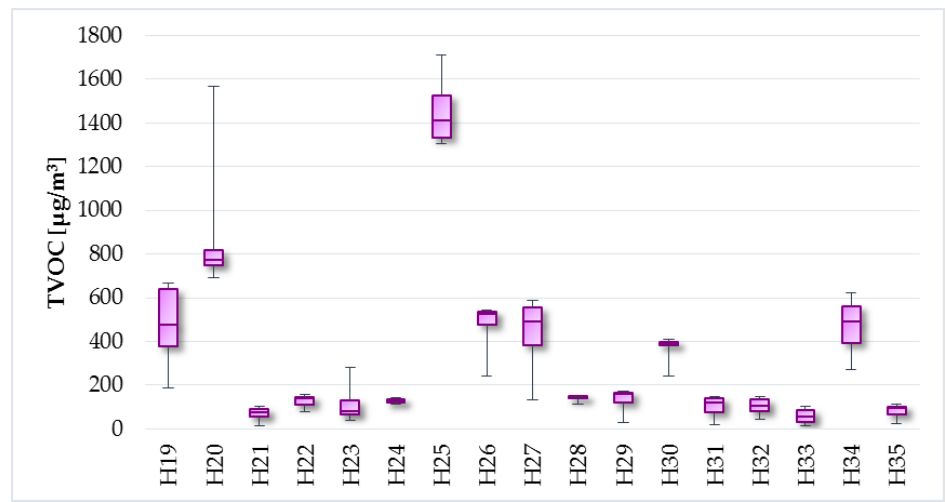
Figure 10. TVOC concentrations—the family houses.